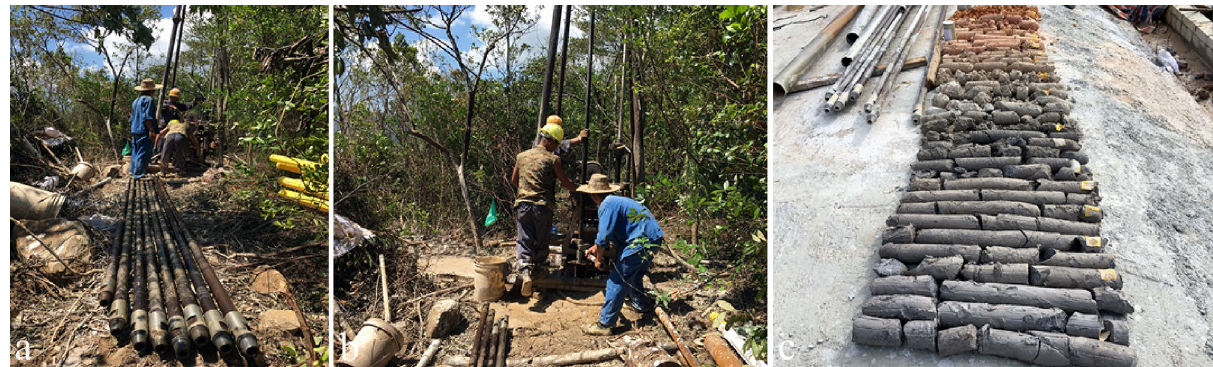
Figure 5. Drilling detection construction processes: ( a,b ) Drilling process and drill pipe installation; ( c ) complete core sample taken from